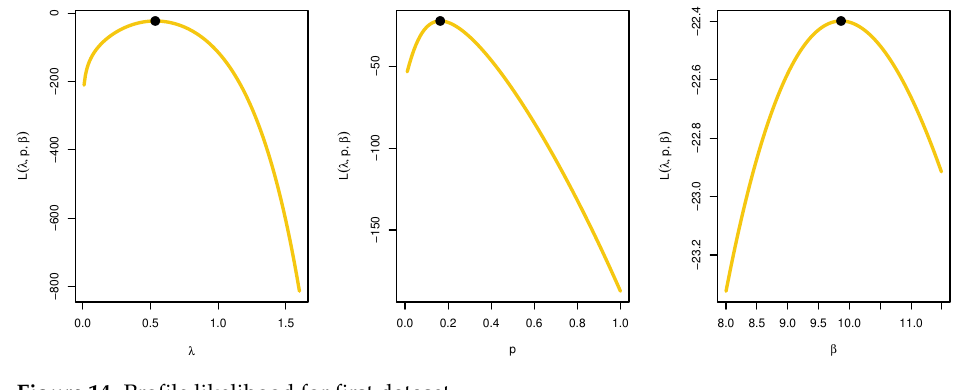
Figure 14. Profile likelihood for first dataset.